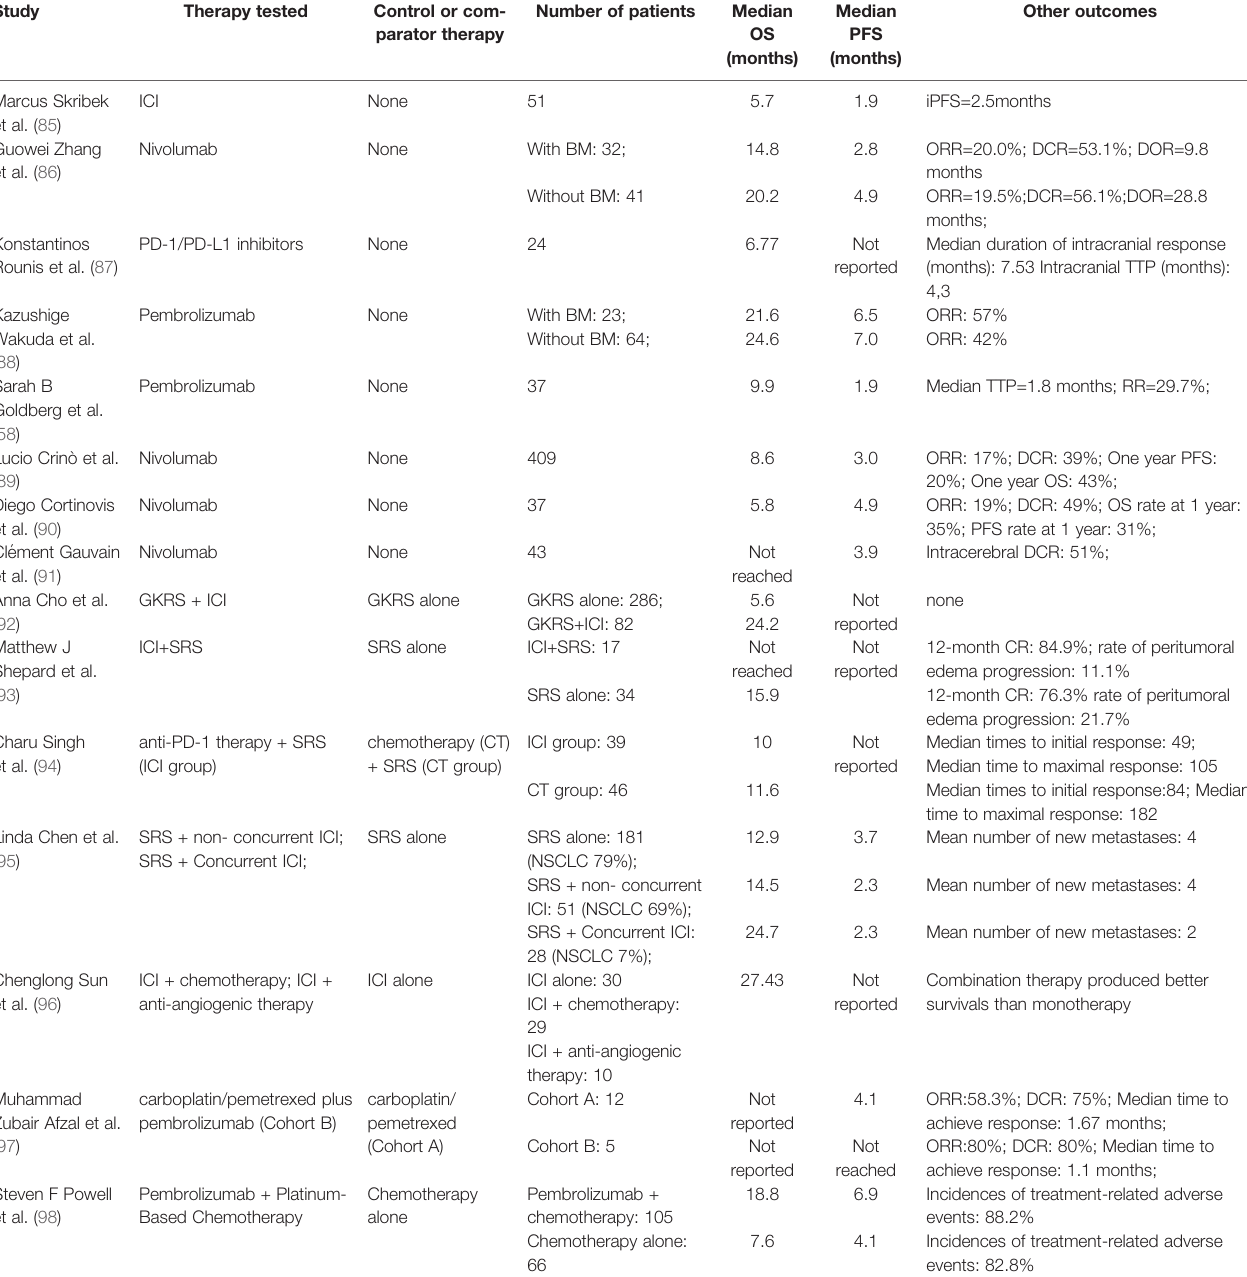
TABLE 3 | Update of immunotherapy in NSCLC